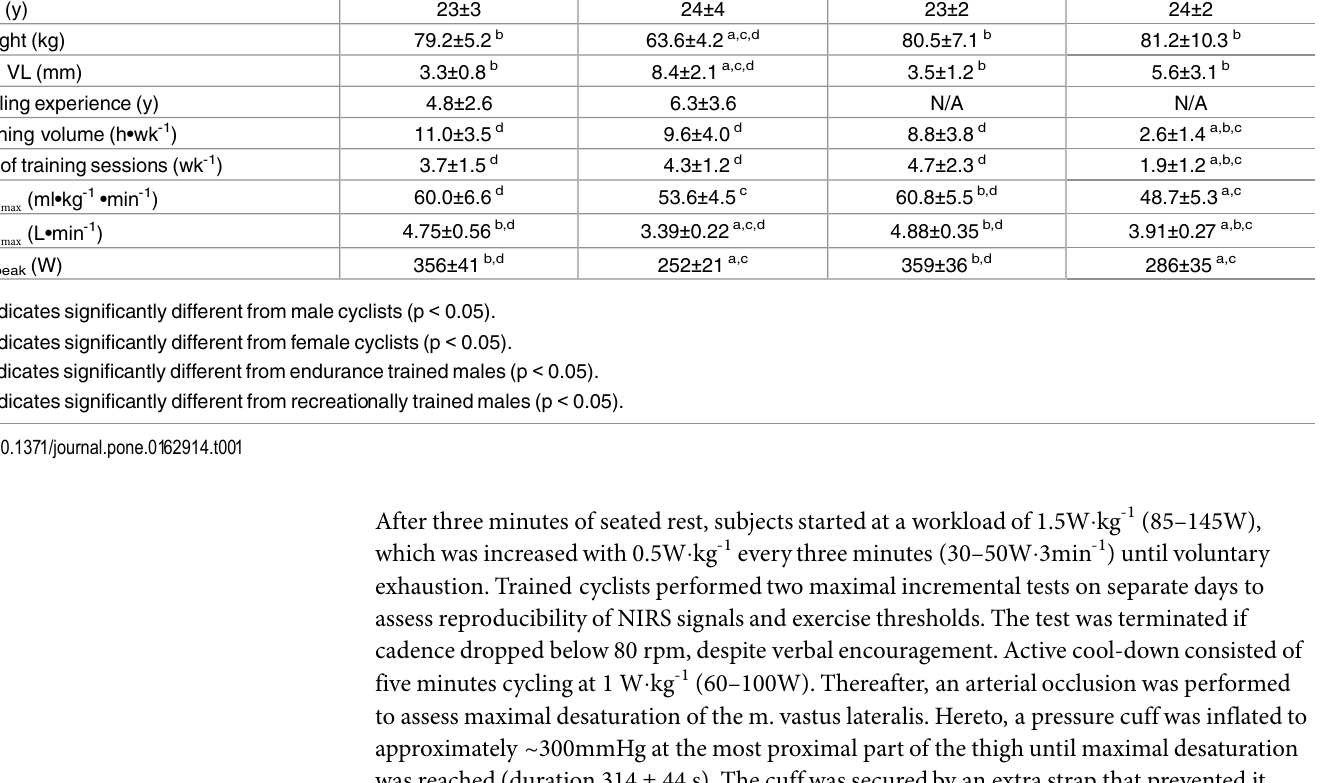
Table 1. Subjectcharacteristics.